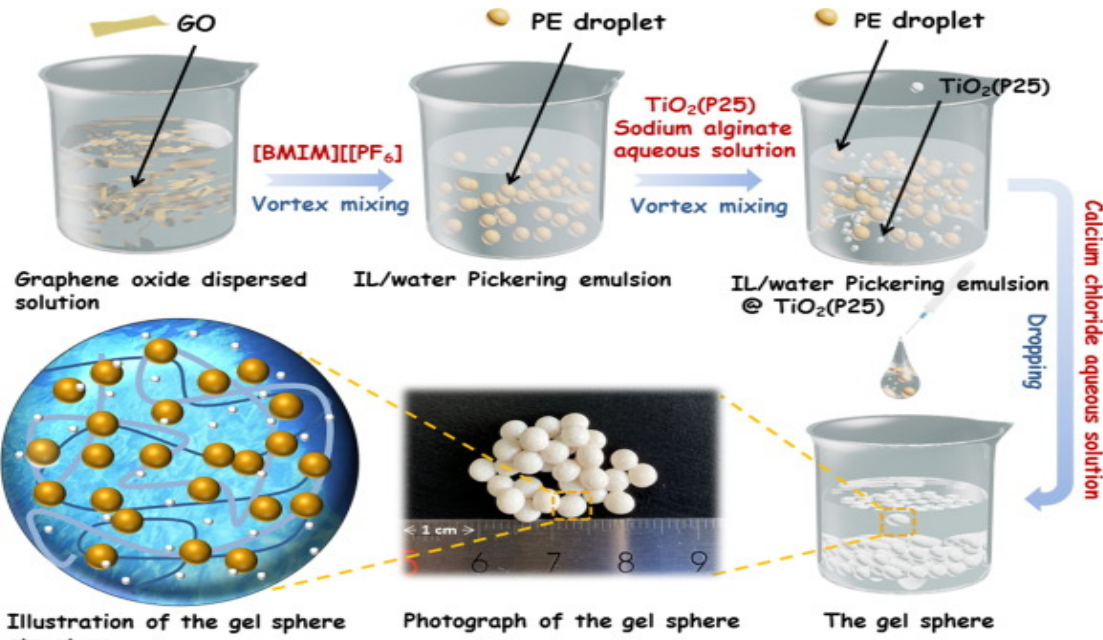
Figure 7. Schematic of the preparation process of the gel sphere [34]. The preparation of aerogels with immobilized TiO 2 nanoparticles for wastewater re- mediation practices is an additional application of alginate salts. Exploring once again homogeneous dispersion and ionic crosslinking pathways, Dai et al. [35] fabricated TiO 2 - alginate aerogels for oil/water separation. After the formation of hybrid sodium alginate- TiO 2 sol with the aid of ultra-sonication, the sol was freeze-dried, while the formed hybrid aerogel was immersed latter into a CaCl 2 solution for the cross-linking step. An additional freeze-drying stage was followed after the washing of cross-linked aerogel. XRD patterns showed a similarity of the composite aerogels’ diffraction peaks to those of the pure TiO 2 , implying that all the followed treatment steps did not affect the crystal form of TiO 2 na- noparticles. SEM images (Figure 8) also showed that the formed aerogels exhibited a 3D porous design, while authors proposed that the rough surface of the sodium alginate-TiO 2